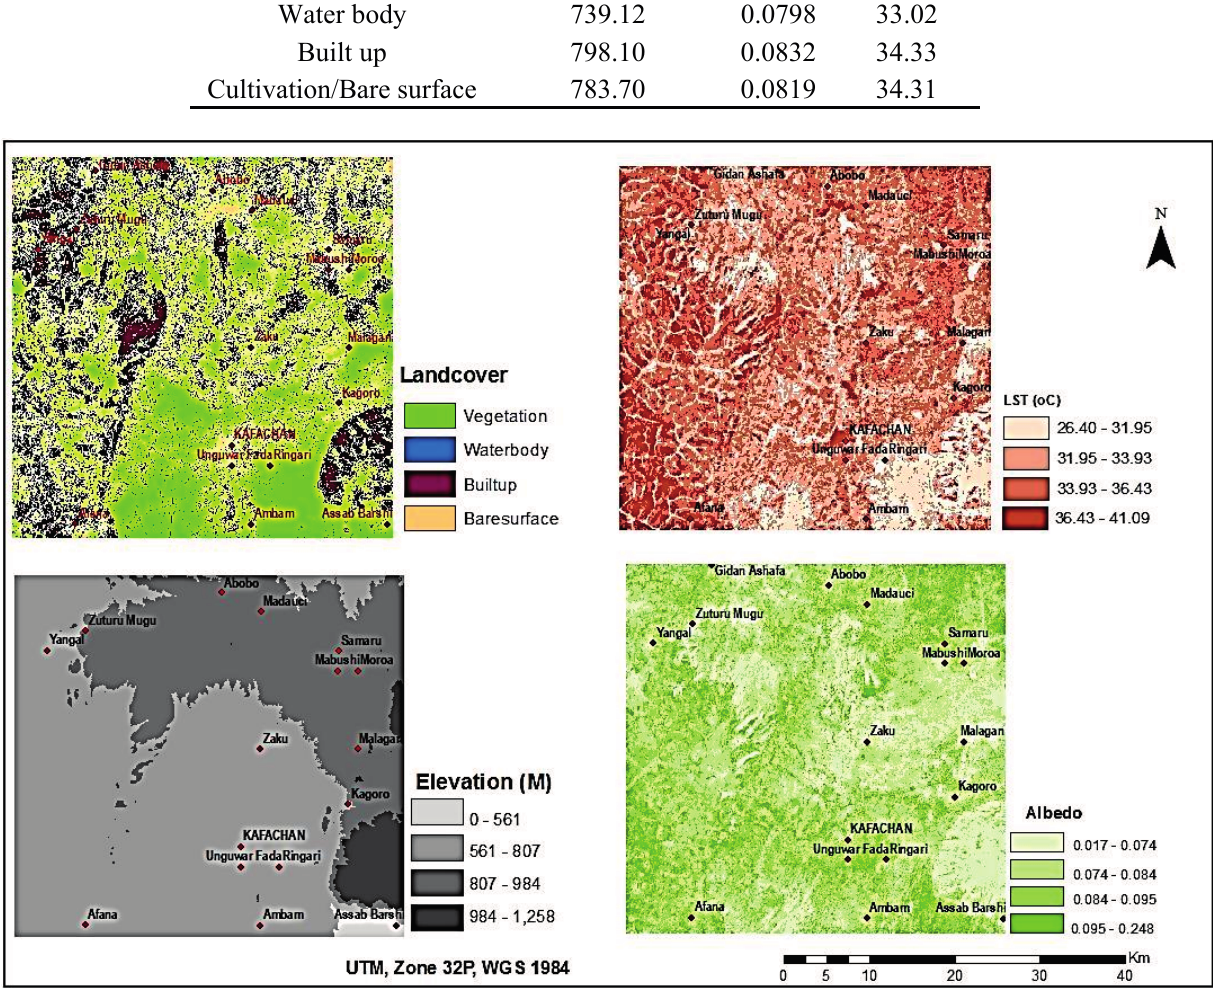
Figure 11. Landcover, LST, topography and albedo in Kafanchan in 2014.